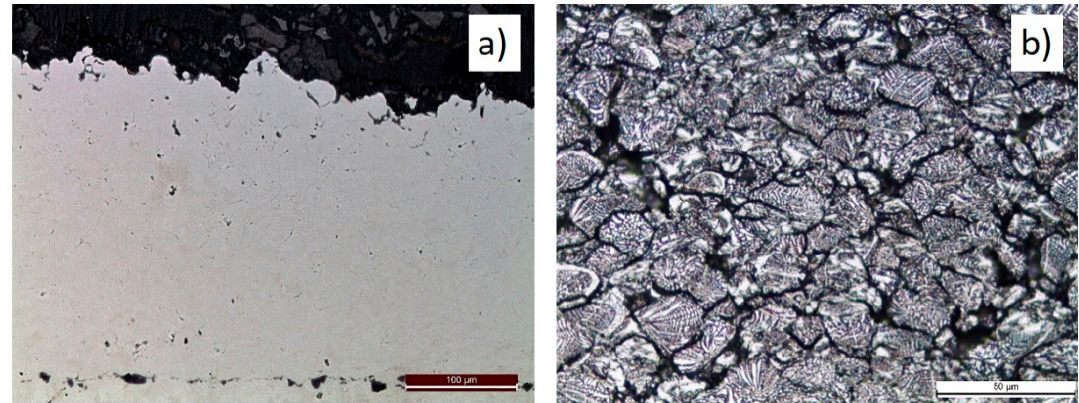
Figure 2. Coating’s cross section microstructure after polishing ( a ) and after etching ( b ). The coatings showed a percentage porosity of 1.3 ± 0.1 and a mean flattening ratio of 2.6 ± 0.3. The porosity results were very low. In general, the flattening ratio